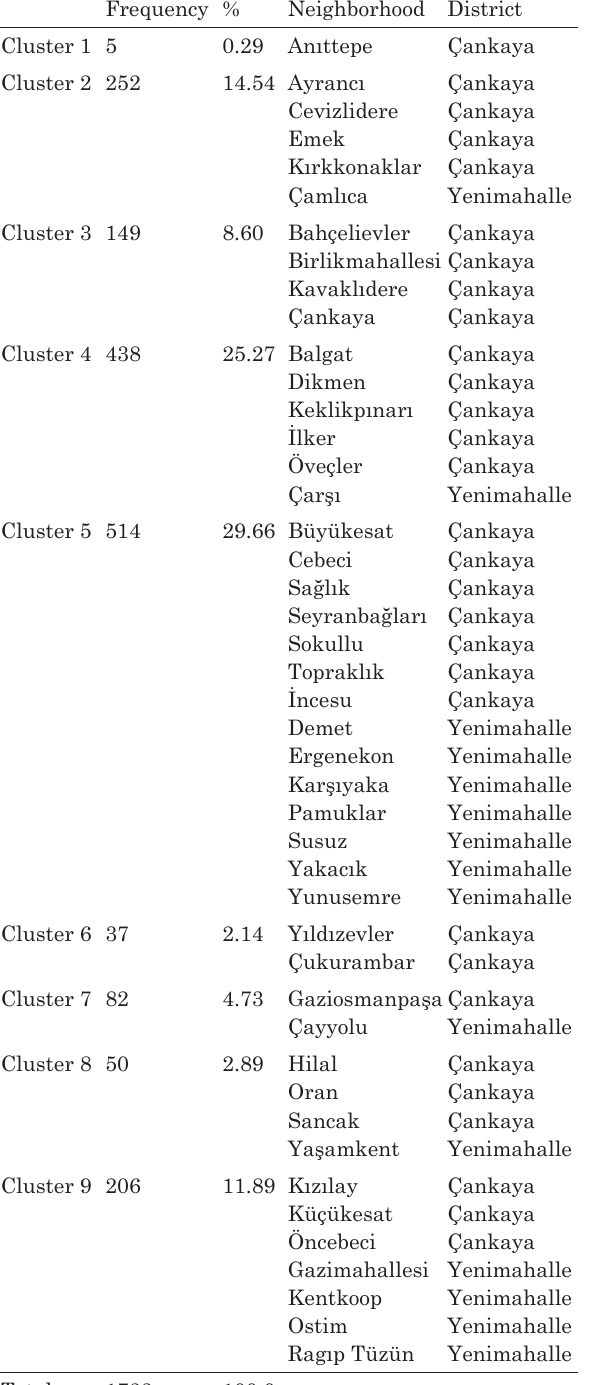
Fig. 2. Spatial distribution of